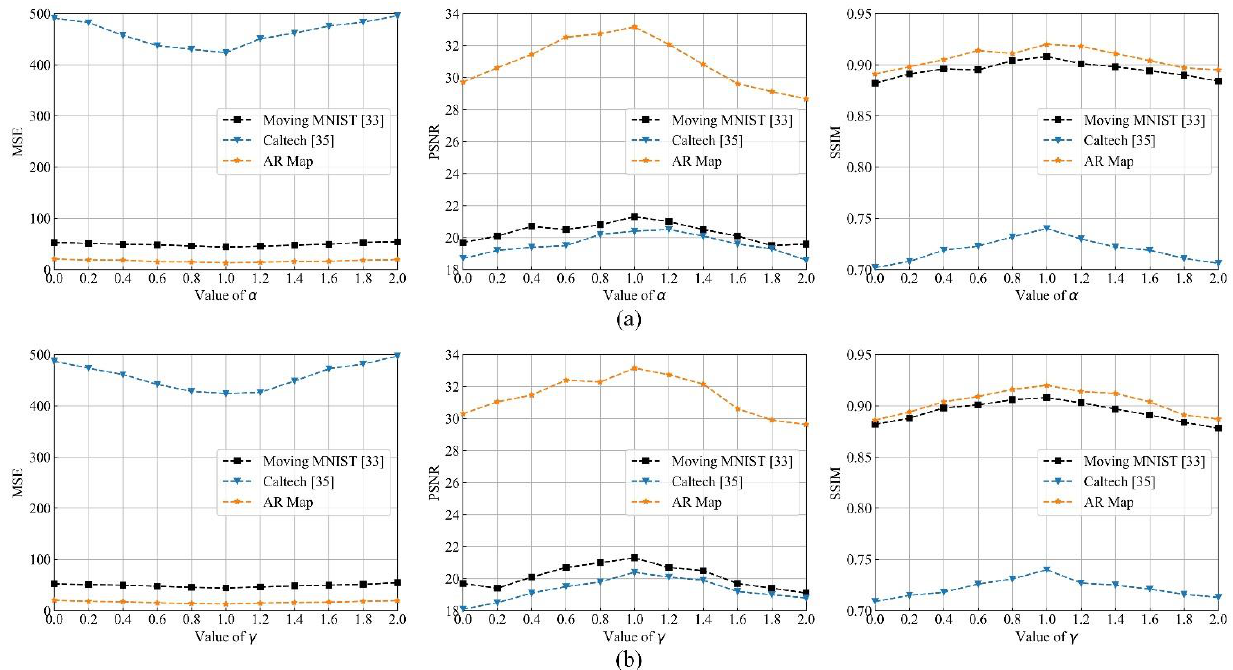
Figure 8. Prediction performance in different αs ( a ) and γs ( b ) at different datasets from top to bottom, left to right, re- spectively.